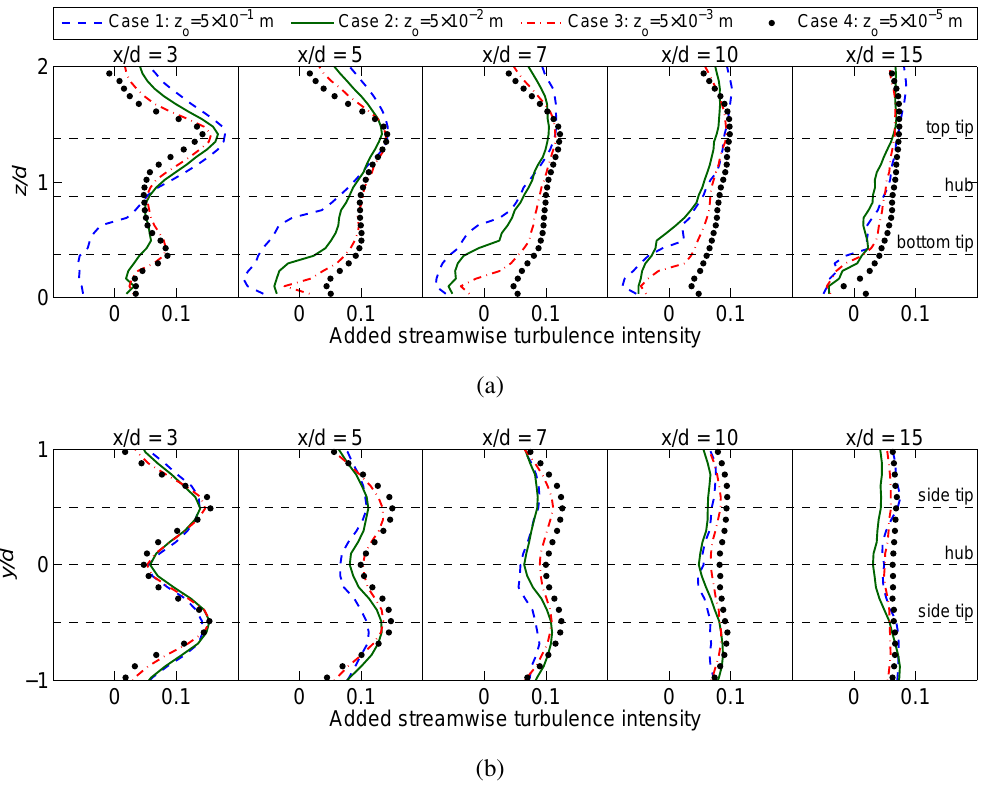
Comparison of vertical ( a ) and lateral ( b ) profiles of the added streamwise turbulence intensity I through the hub level of the turbines installed on flat u,add